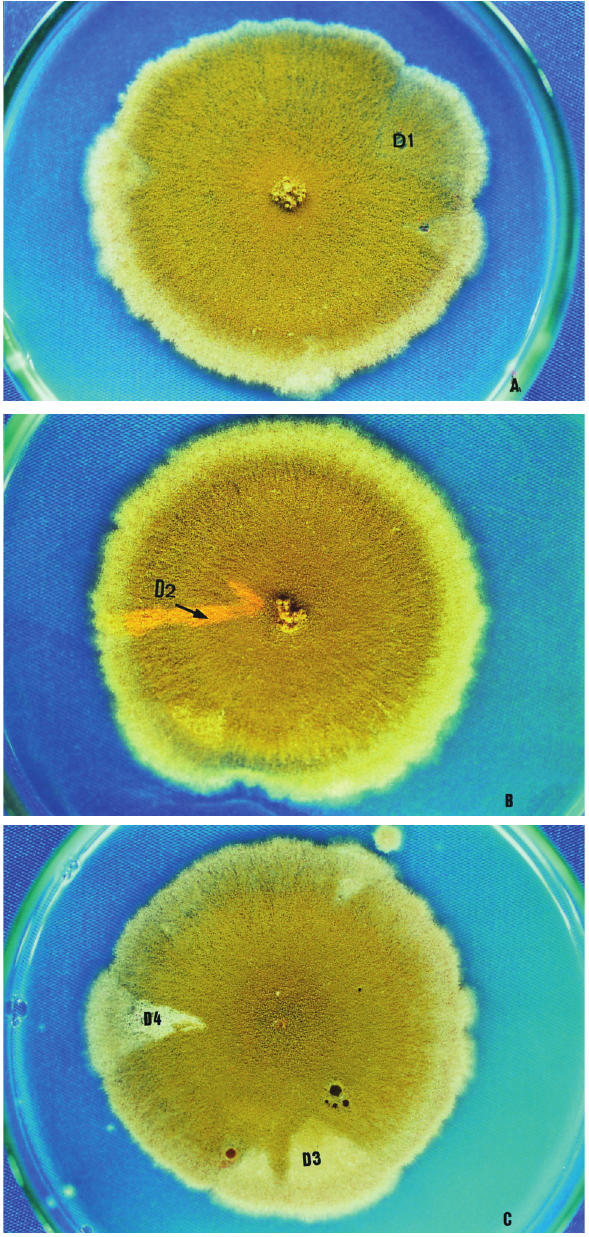
Figure2 -DiploidsD1,D2,D3andD4derivedfromtheZ1//A757diploid strain after treatment with 4.0 x 10 –3 µ M (D1) and 5.0 x 10 –3 µ M (D2-D4) of ethidium bromide in Minimal Medium.